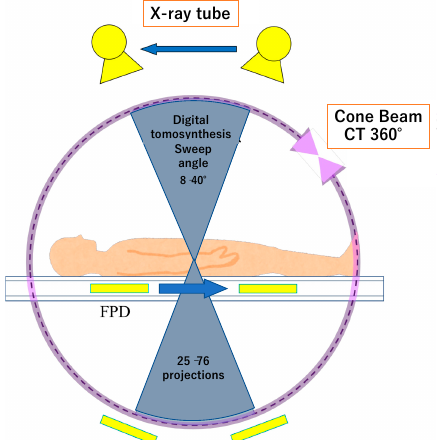
Figure 1. Basic principle of digital tomosynthesis (DT). DT acquires image data by a single sweep of an X-ray tube, with a range of 8 to 40°, whereas that of cone beam computed tomography is 360°. The X-ray is detected by digital flat panel detectors (FPD), which are either in the same position or may move in the opposite direction to the X-ray tube depending on the tables.